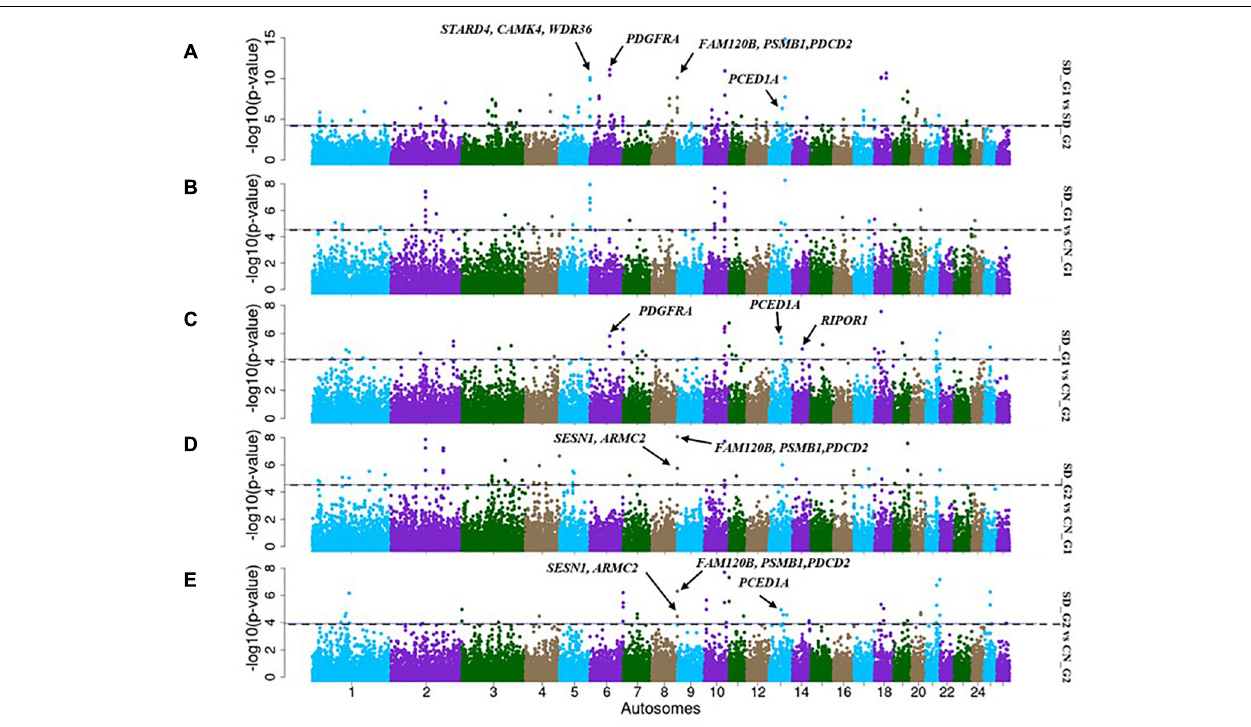
FIGURE 6 | Manhattan plots showing the candidate signatures of selection as determined with F ST . (A) SD_G1 vs. SD_G2; (B) SD_G1 vs. CN_G1; (C) SD_G1 vs. CN_G2; (D) SD_G2 vs. CN_G1; (E) SD_G2 vs.